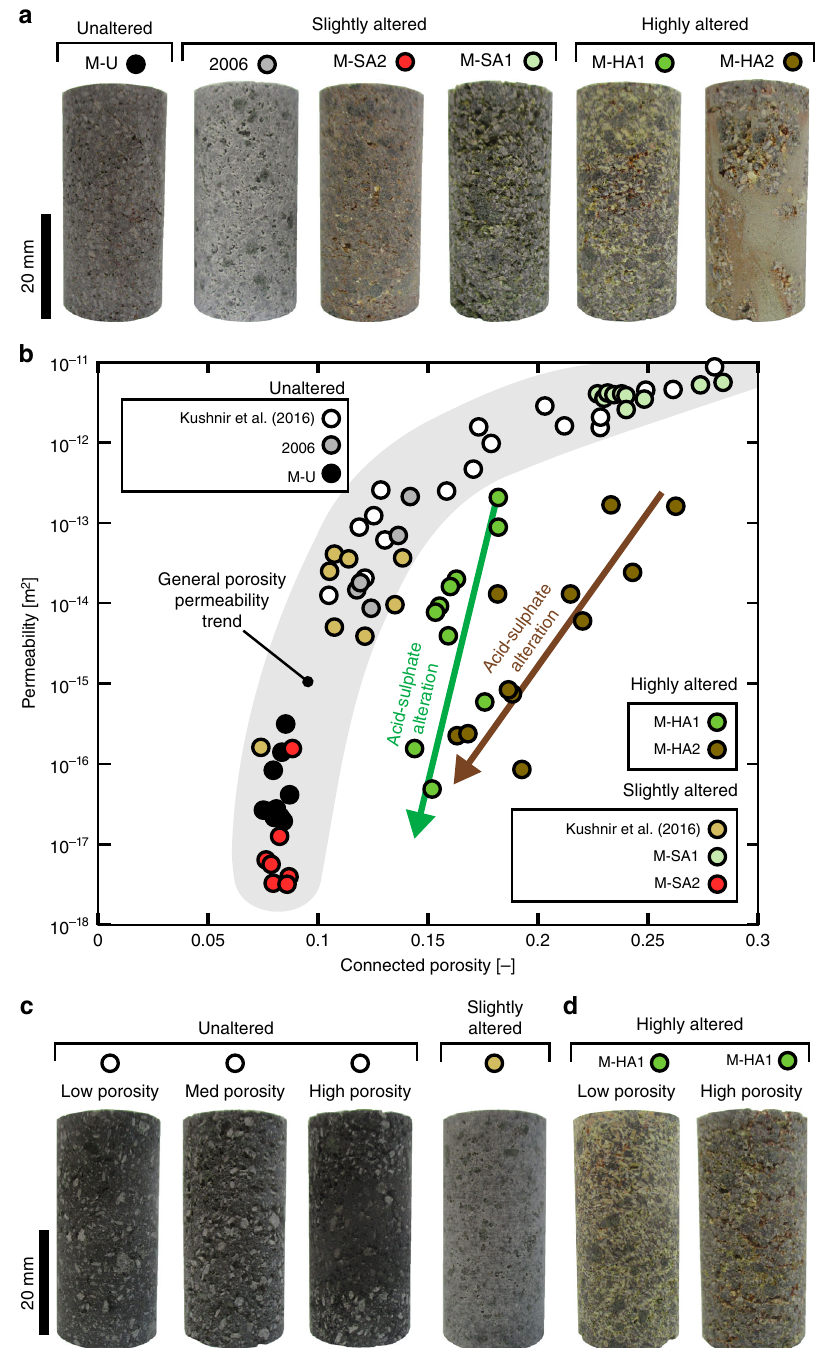
Fig. 1 Porosity-permeability trends for unaltered and altered dome rocks. a Photographs of representative 20-mm diameter core samples prepared from each of the blocks collected for this study. b Permeability as a function of connected porosity for dome rocks from Merapi volcano (data from this study and Kushnir et al. 44 ). Grey zone shows the general porosity-permeability trend for lavas from Merapi volcano and the arrows show porosity-permeability trajectories for acid-sulphate altered lava dome samples. The experimental error on these measurements is <1% and is therefore within the symbol size. c Photographs of representative 20-mm diameter cores from the unaltered and slightly altered (containing cristobalite) samples from Kushnir et al. 44 . d Photographs of two 20-mm-diameter core samples prepared from block M-HA1 that preserve different degrees of